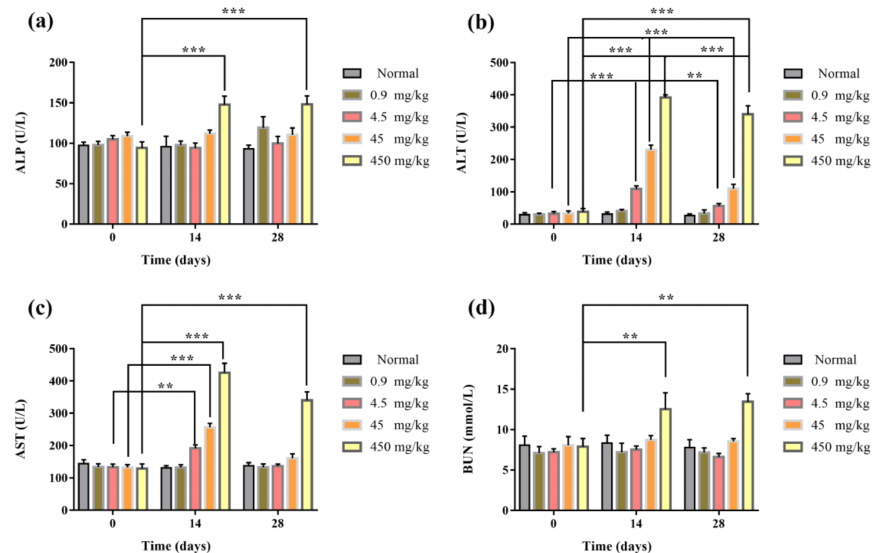
Figure 8. Blood biochemical indexes of mice injected via tail vein with 200 µ L of Fe 2 O 3 /Fe 3 O 4 heterogeneous nanoparticles solutions of various concentrations: ( a ) alkaline phosphatase (ALP), ( b ) alanine aminotransferase (ALT), ( c ) aspartate aminotransferase (AST), and ( d ) blood urea nitrogen (BUN) (the control groups were injected with the same volumes of normal saline). ** p ≤ 0.01, *** p ≤ 0.001 versus control group, n = 6.